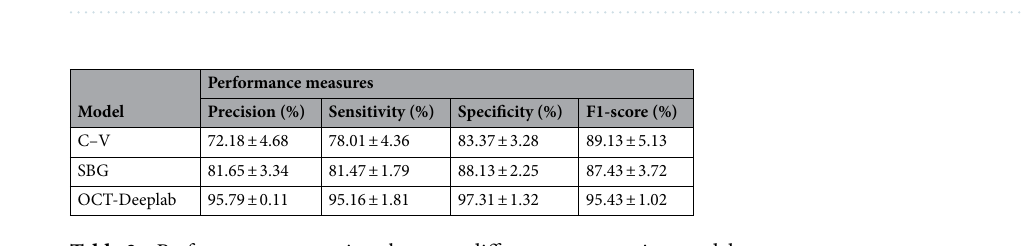
Table 2. Performance comparison between different segmentation